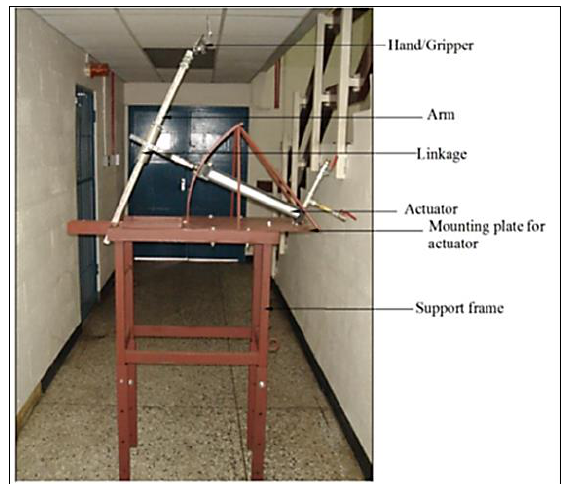
Figure 1. Working bowling arm prototype [17]